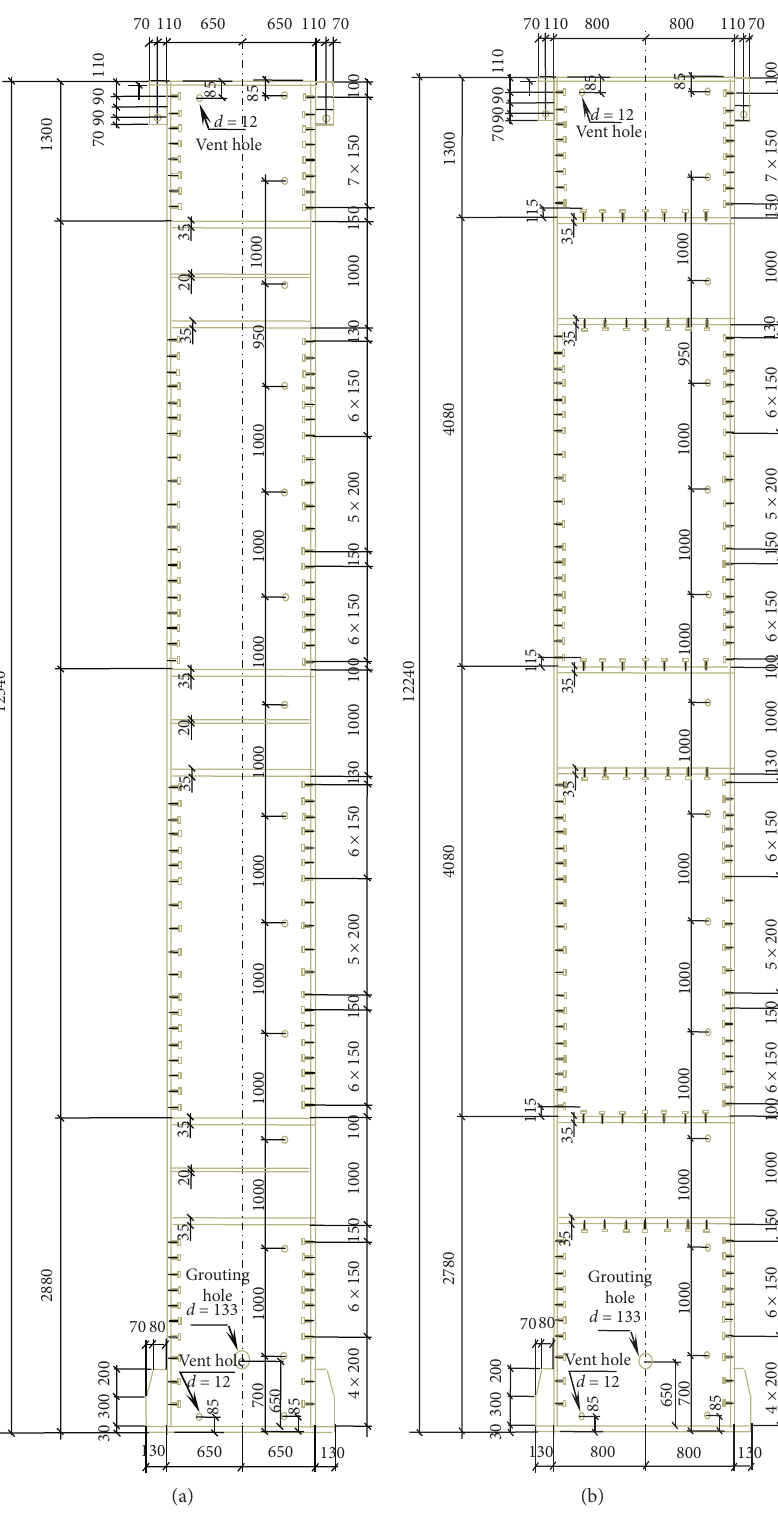
Figure 2: Design drawings of CFST columns used in engineering (unit: mm). (a) SYZ-1 test column. (b) SYZ-2 test